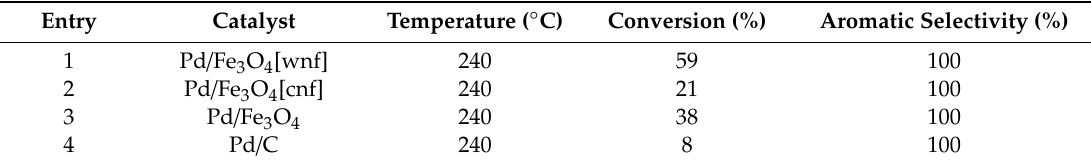
Table 1. Main characteristics of the supported palladium catalysts investigated (S.A.: surface area; d n : mean particle size from TEM). Table 2. Performance of investigated Pd-based catalysts in the transfer hydrogenolysis of benzyl phenyl ether (BPE) in the presence of 2-propanol as solvent / H-source (reaction conditions: 0.125 g of